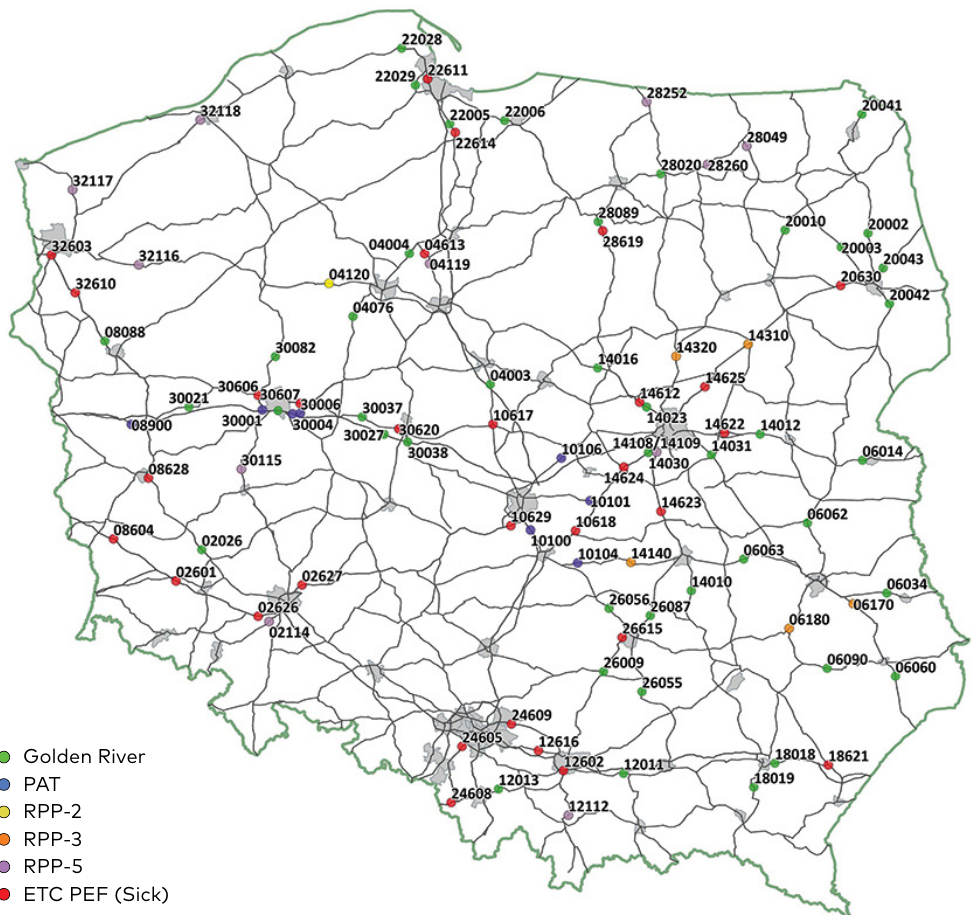
Figure 1. Map of places of automatic traffic recording stations in Poland by the General Directorate for National Roads and Motorways of